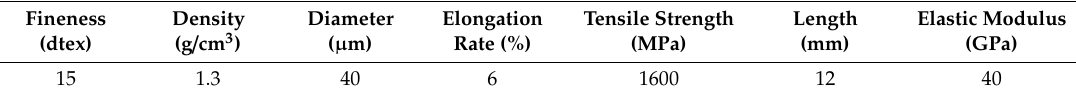
Table 4. Physical properties of K-II polyvinyl alcohol (PVA)